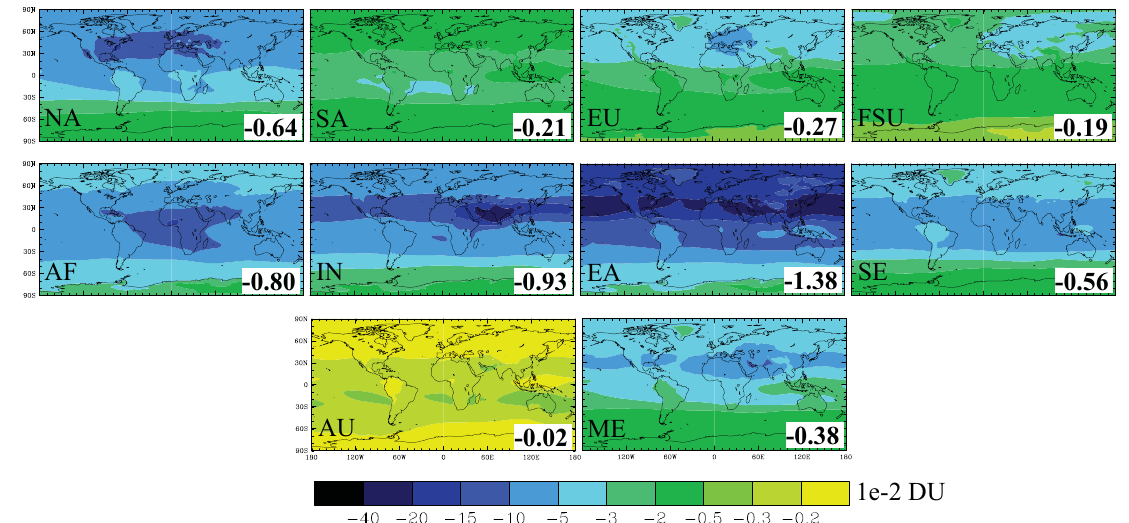
Fig. 6. Global distribution of annual average changes in tropospheric total column O 3 at steady state (1 × 10 − 2 DU) for each of the regional reduction simulations relative to the base. The global annual average steady-state tropospheric O 3 changes (Tg O 3 ) for each simulation are noted in the lower right of each panel.